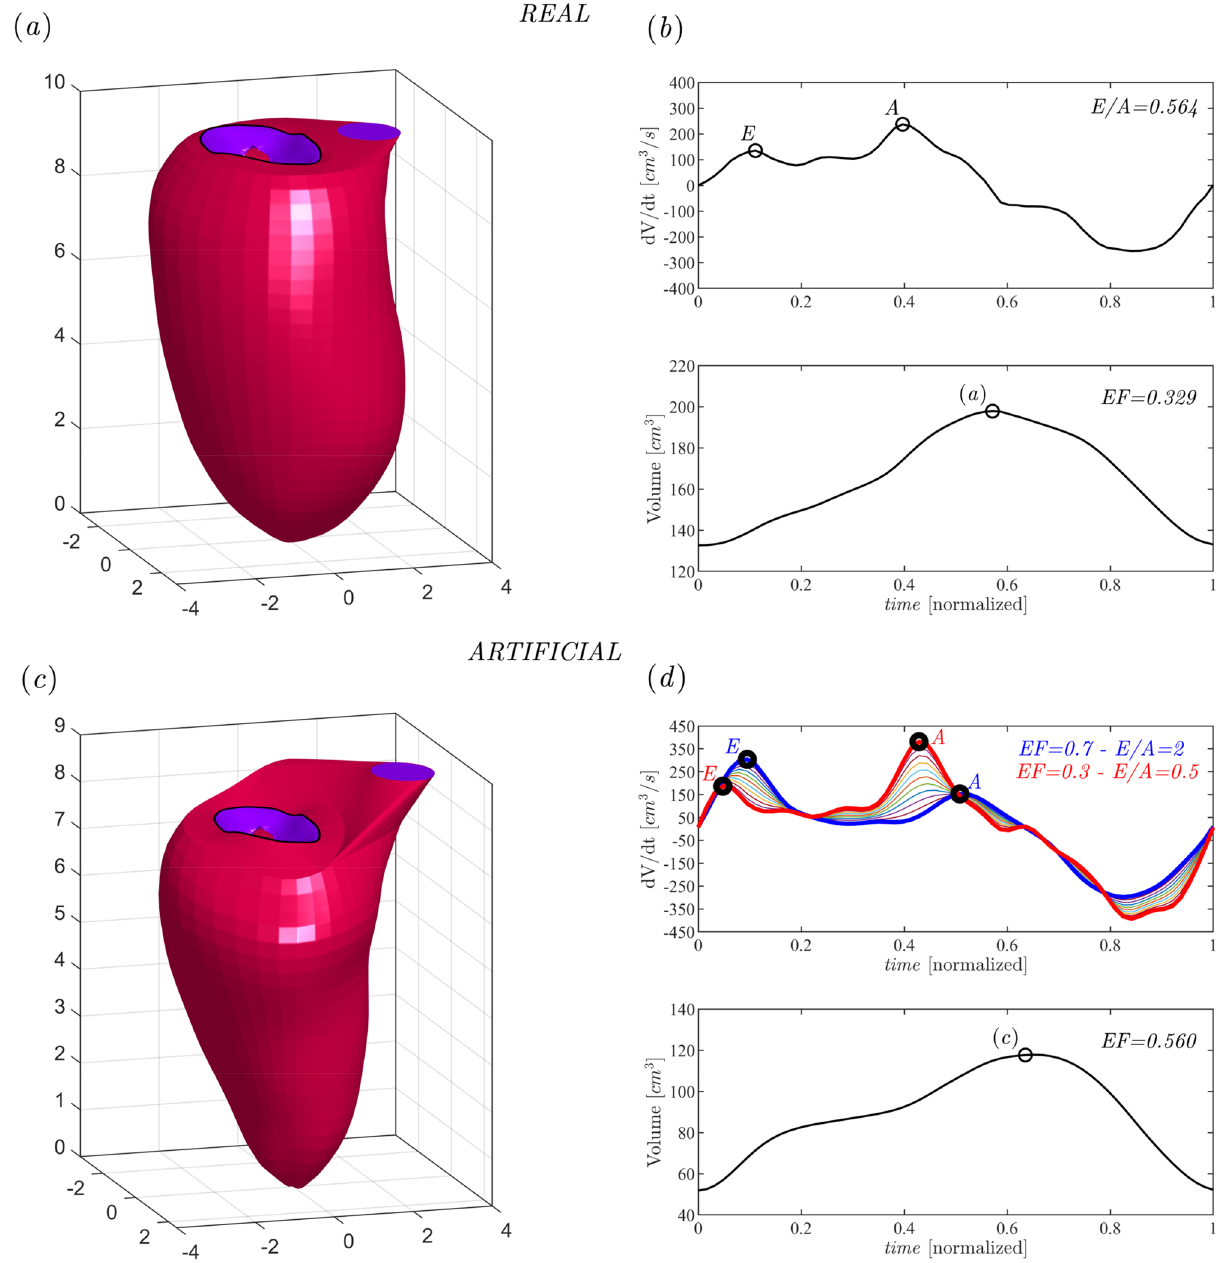
Figure 6. First row: panel ( a ) shows the LV geometry for a patient-specific case; panel ( b ) shows the correspondent volume curve and dV / dt with values of EF and E / A displayed. Second row: panel ( c ) depicts a synthetic LV obtained with the parameterized geometry; panel ( d ) depicts the correspondent volume curve and dV / dt where the general approach for the construction of the synthetic cases for given values of the governing parameters is